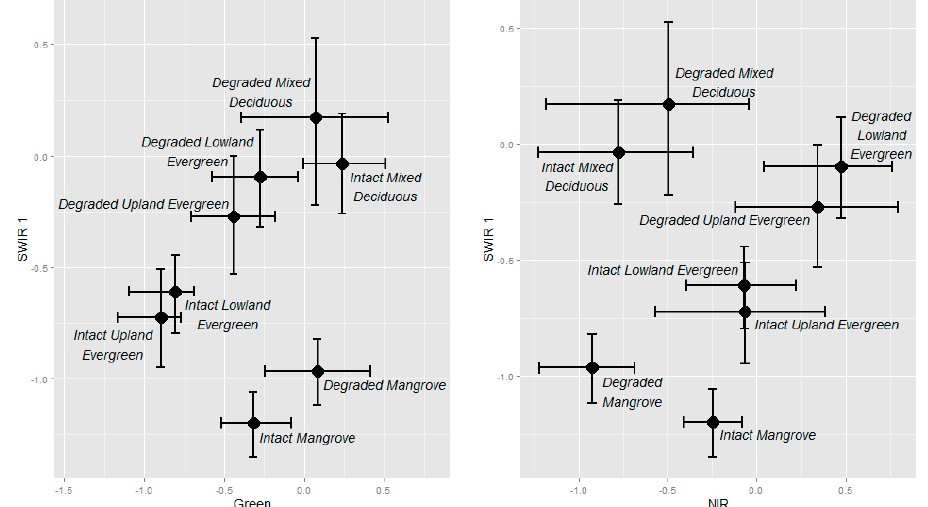
Figure 4. Normalized Top of Atmosphere Reflectance (TOA) of training data by forest type. Points indicate mean values while error bars depict upper and lower quartiles for Landsat 8 bands 3 (green), 5 (near infrared), and 6 (shortwave infrared 1). For each band, normalized reflectance was calculated by subtracting the mean and dividing by the standard deviation of the training data sample.